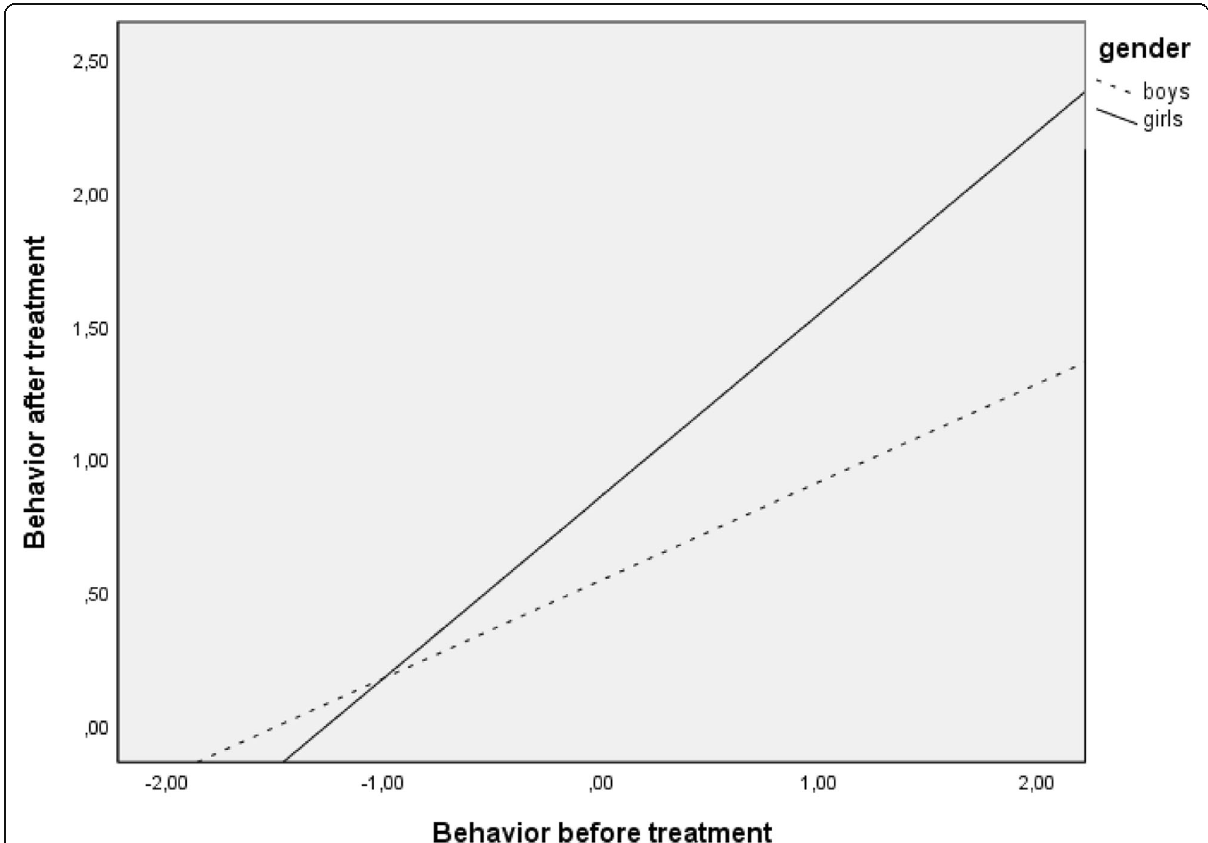
Fig. 1 Relationship between behaviour before and after treatment depends on gender